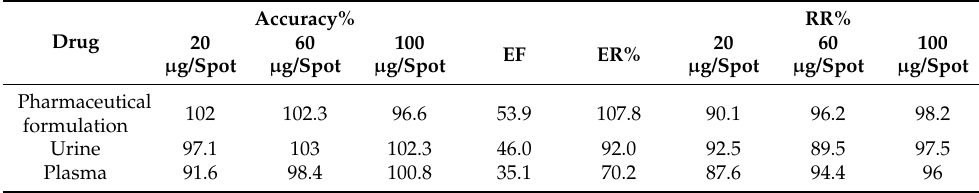
Table 2. Extraction efficiency parameters of the proposed method ( n =